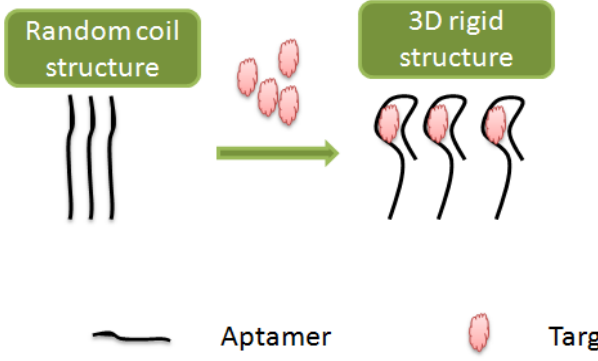
Figure 2. Principle of structure switchable aptamer-assays.